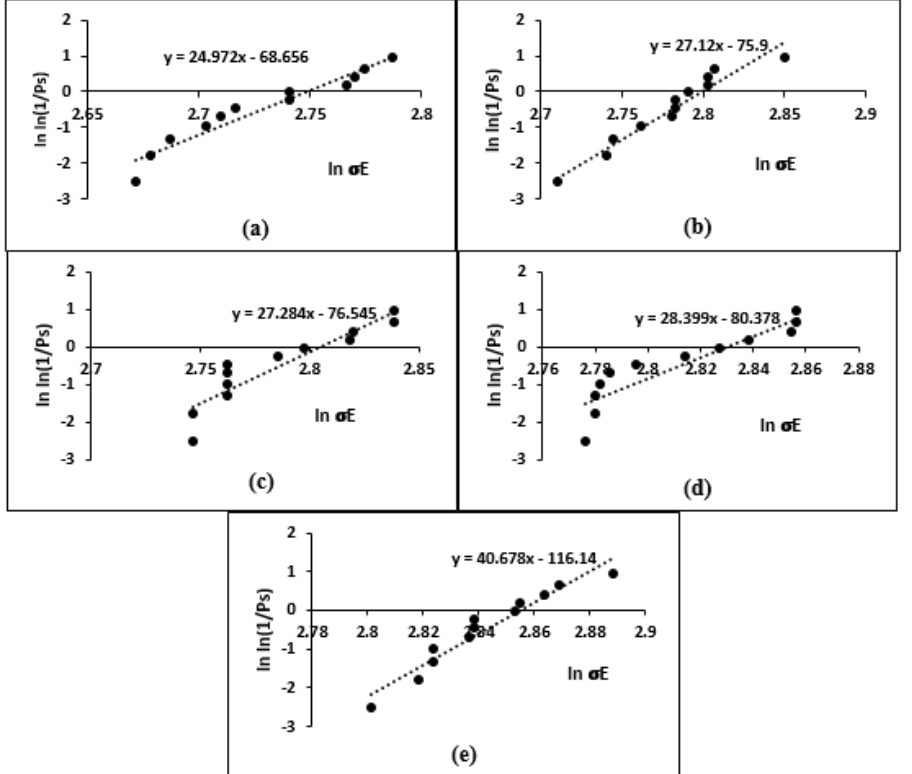
Figure 6: Weibull distribution of dielectric strength at various RRV: (a) 0.5, (b) 1, (c) 2, (d) 3 and (e) 5 kV/s, for 4 wt% Al 2 O 3